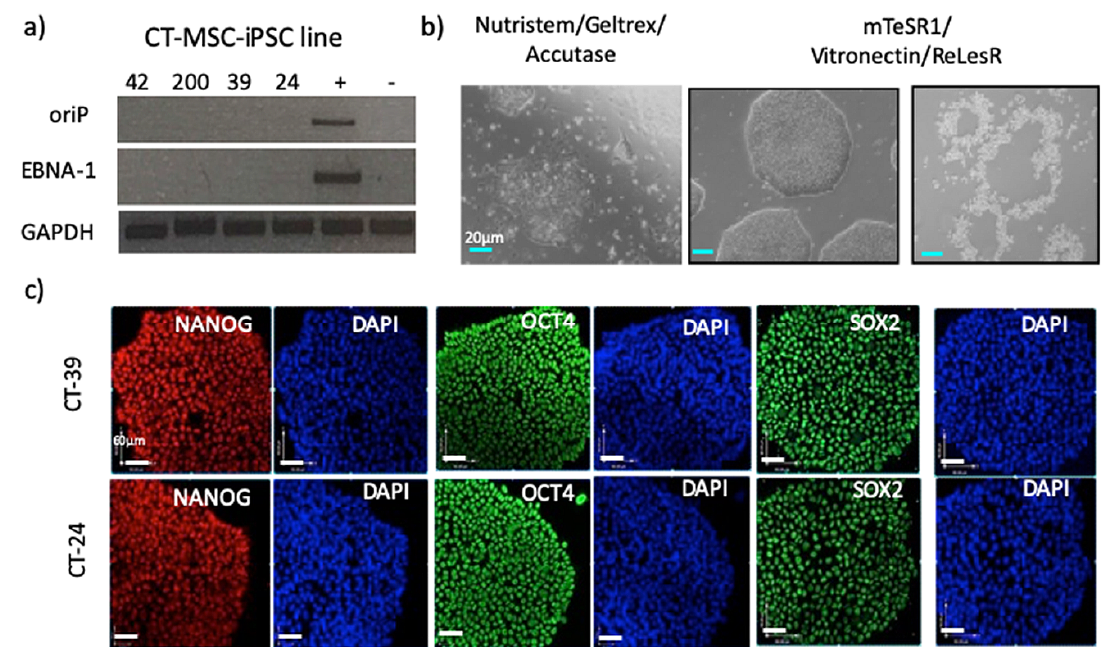
Figure 3. Vector-free pluripotency cell lines established from CT-MSC. ( a ) The CT-induced pluripotent stem cell (iPSC) lines are negative for the OriP and EBNA genes of the episomes carrying the reprogramming factors by passage 10, indicating the loss of the episome after reprogramming has completed. The positive control (+) is an earlier passage 3 of the CT-42 iPSCs lines still containing the reprogramming vectors, and the negative control ( − ) is a human embryonic stem cell (ESC) line (CA1). ( b ) Phase contrast images of the morphology of CT-MSC iPSCs grown in Nutristem on Geltrex matrix compared to mTeSR on Vitronectin matrix. Distinct, uniform colonies with defined borders are observed only with mTeSR1 medium with Vitronectin-coated plates. The iPSC colony can be easily lifted from the plate using ReLeSR leaving behind the differentiated cells that sometimes form at the outer edges of pluripotent stem cell colonies. Scale bar = 20 µm for all panels. ( c ) Vector-free CT-MSC-iPSC lines express pluripotency markers Nanog, Oct4 and Sox2 as detected by immunocytochemistry. Scale bar = 60 µm for all panels.